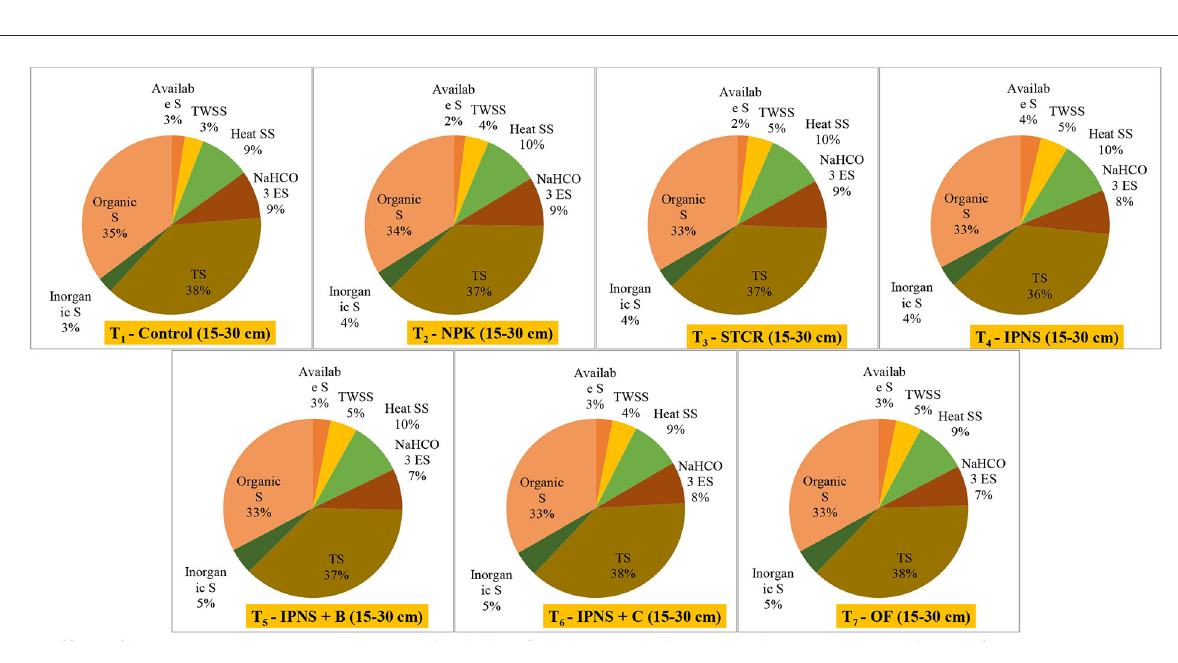
Impact on total sulfur The plot with OF indicated its significant superiority over the rest of the treatment combination (Tables